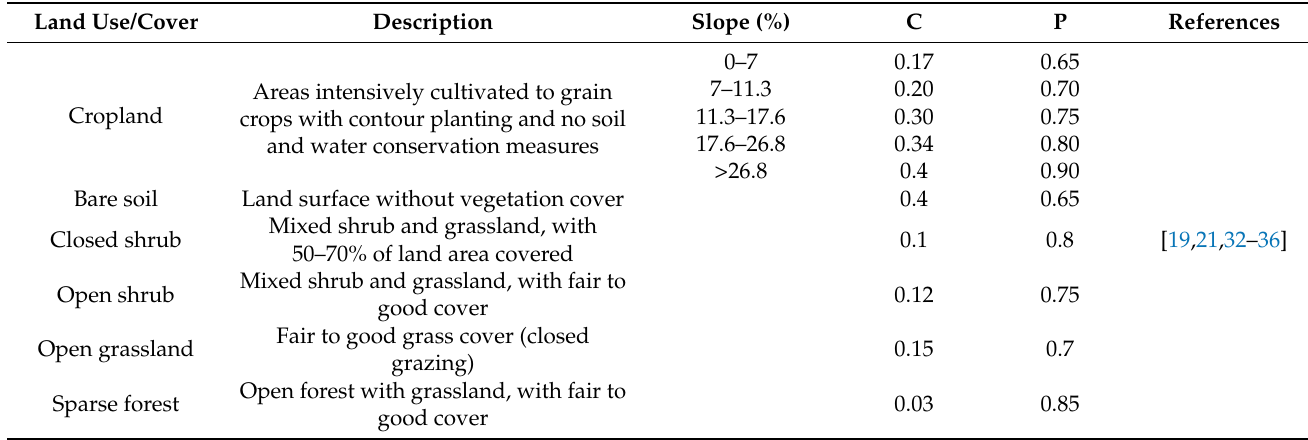
Table 1. Land cover and management (C factor) and support practices (P factor) values used to compute soil loss with the revised universal soil loss equation